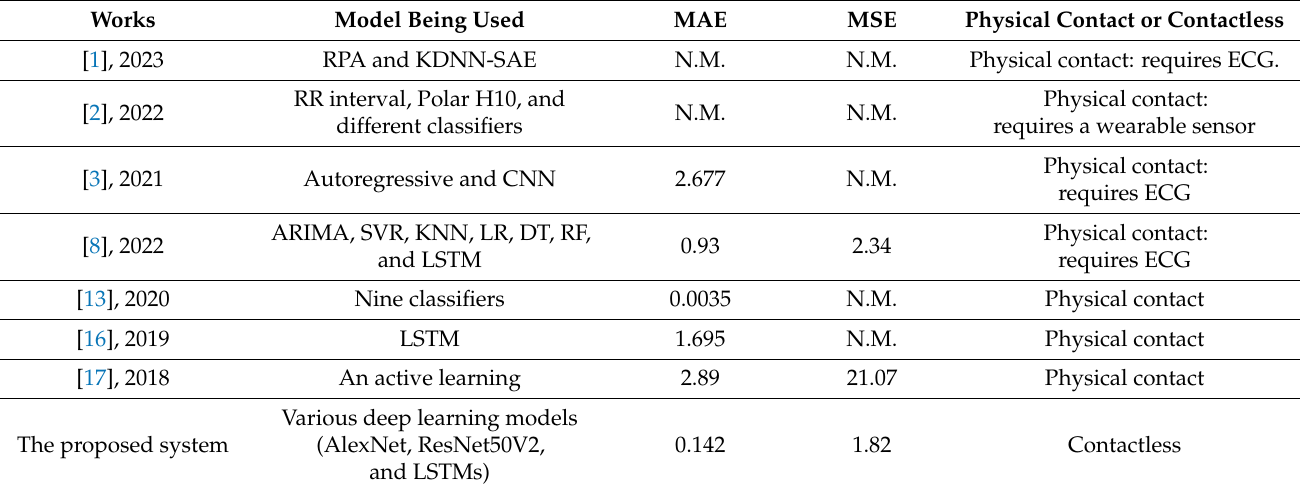
Table 5. The comparative analysis